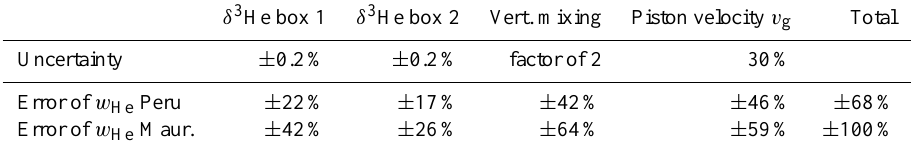
Table 1. Error estimation.